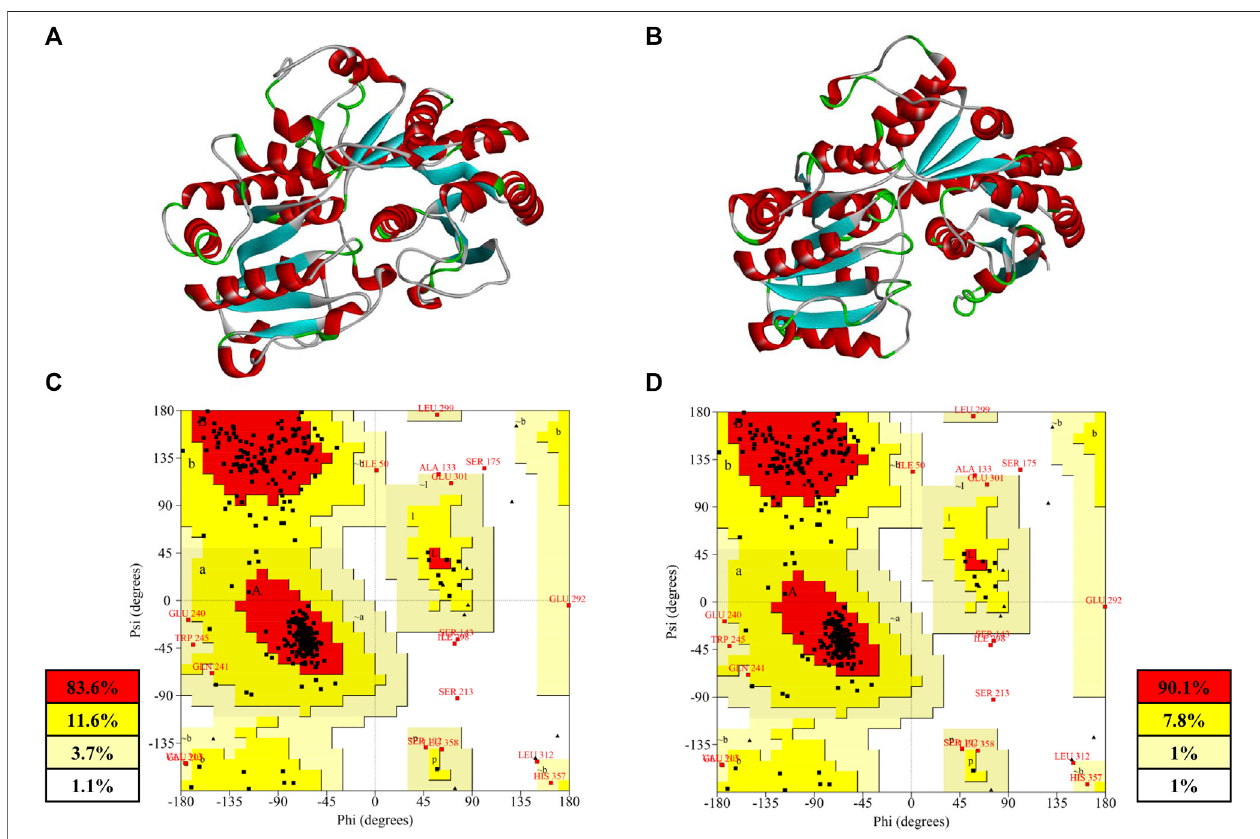
FIGURE4|(A) HomologymodelbuiltbyDiscoveryStudio; (B) deep-learning – basedmodelbuiltbyRoseTTAFold; (C) Ramachandranplotofthehomologymodel; (D) Ramachandran plot of deep-learning-based